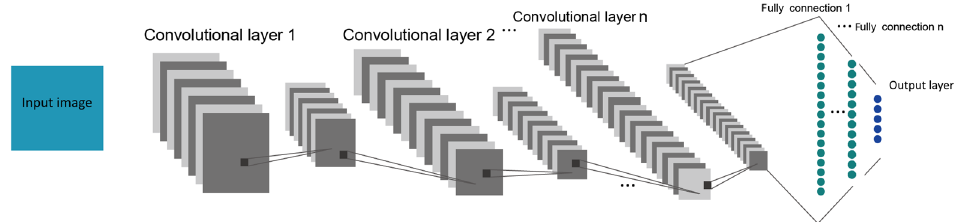
Figure 2. CNN general